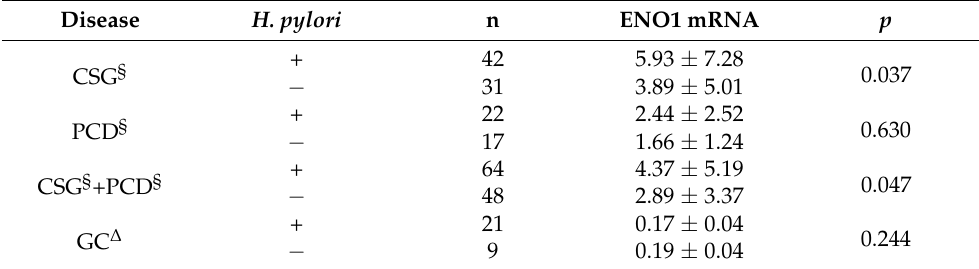
Table 4. Correlation between ENO1 mRNA and H. pylori infection in the gastric tissues.